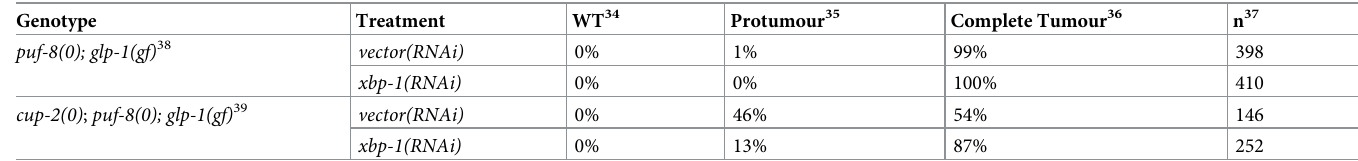
A protumour is defined as a gonad arm with a mass of proliferative cells in the proximal end preceded more distally by presence of sperm and/or eggs as seen by whole mount DAPI staining 36 Complete tumour is defined as a gonad arm that contains only proliferative cells as seen by whole mount DAPI